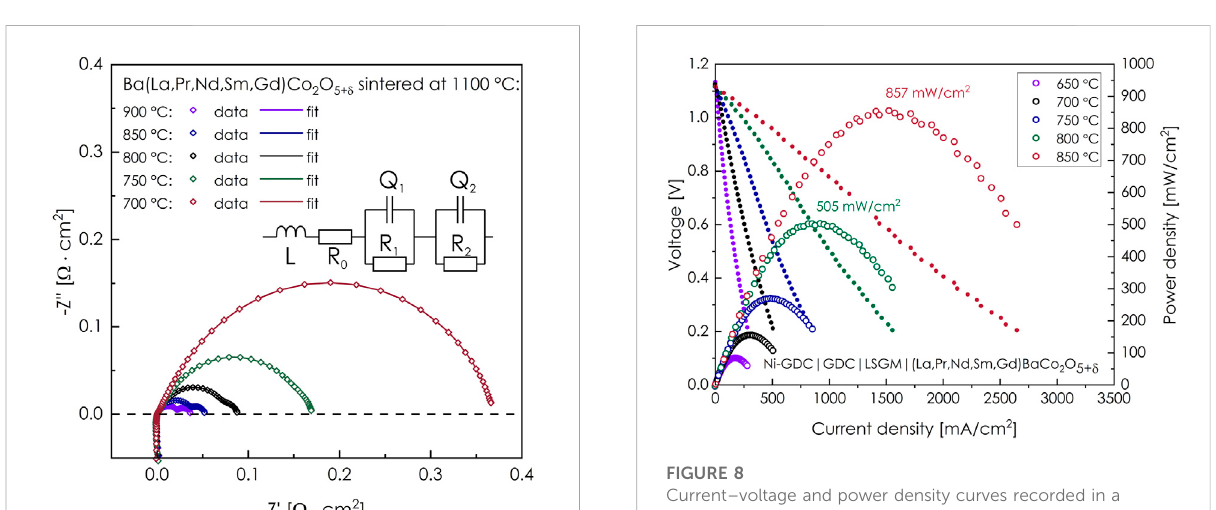
FIGURE 8 Current – voltage and power density curves recorded in a 650 – 850 ° C temperature range for the Ni-Ce 0.8 Gd 0.2 O 2- δ |